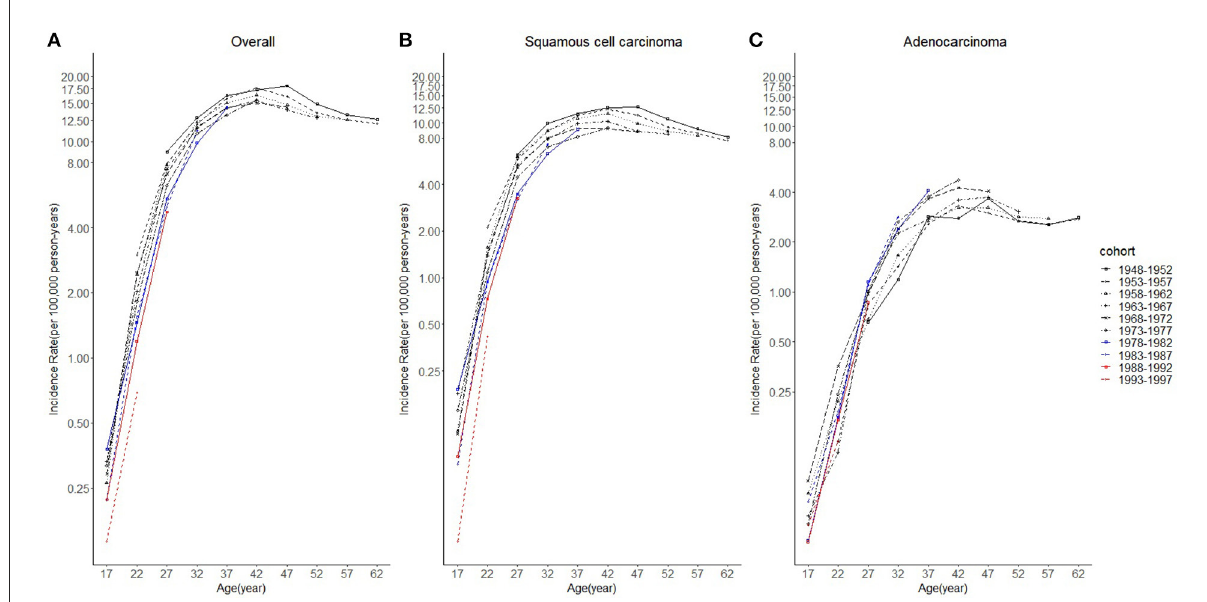
FIGURE5 The log-scale age trends in cervical cancer incidence rates (1975–2019) among females in 1948–1997 birth cohorts by age and histology, United States. (A) Log-scale age trends of all histopathologic subtypes combined. (B) Log-scale age trends of squamous cell carcinoma (SCC). (C) Log-scale age trends of adenocarcinoma (AC). All data are expressed as the rate per 100,000.